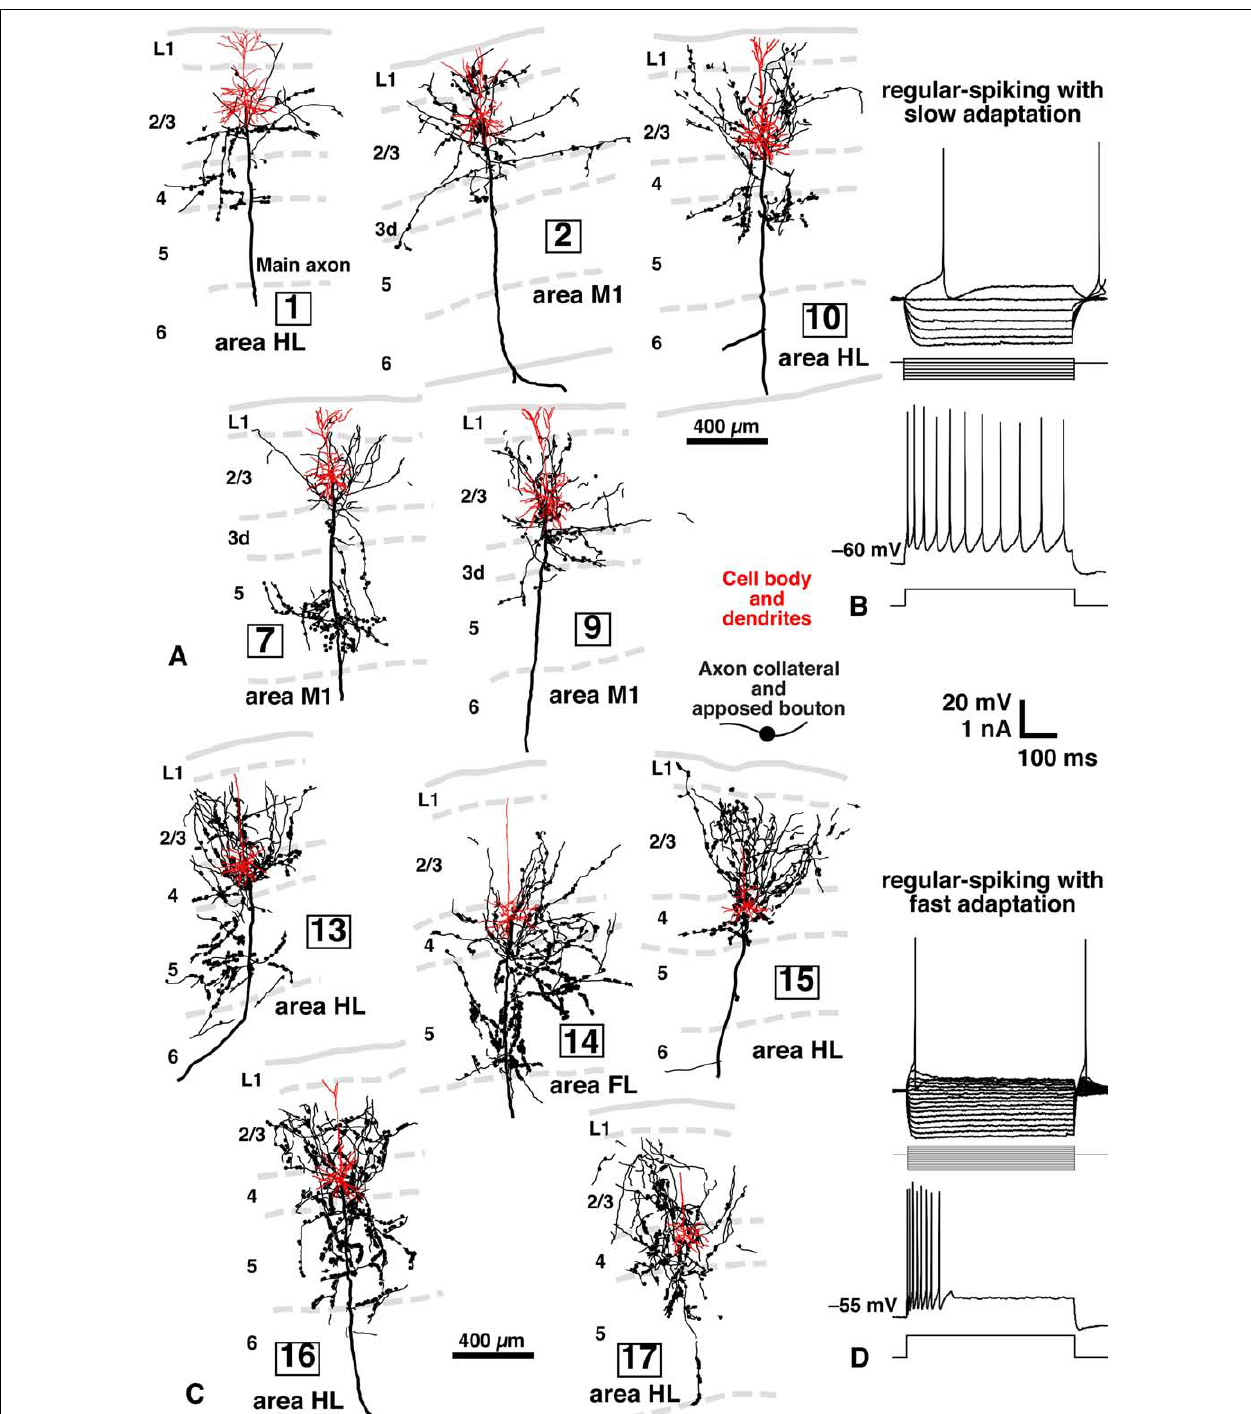
FIGURE 5 | Inputs of L2/3 pyramidal and L3d and L4 spiny neurons to CSNs, and electrical properties of L2/3 and L3d/L4 neurons in rat brain. Many axon boutons of L2/3 pyramidal neurons were in close apposition to the apical or basal dendrites of CTNs (A) . However, unexpectedly, the axons of L3d/L4 star-pyramidal neurons formed more appositions with the dendrites of CTNs (C) than those of L2/3 pyramidal neurons.The two groups of excitatory